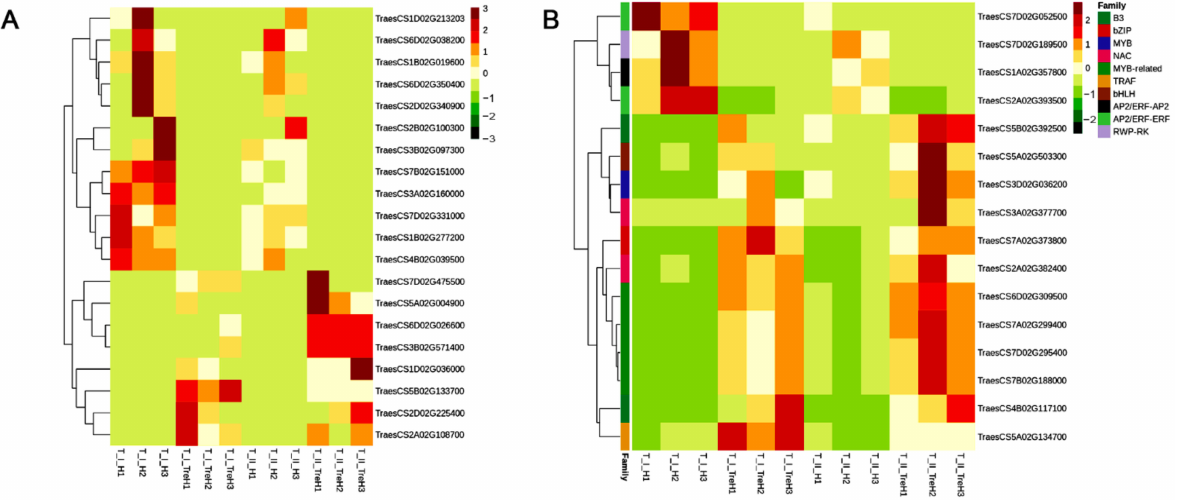
Figure 8. Heatmap of trehalose response candidate genes and transcription factors. T—the tran- scriptome; I—Yangmai 18; II—Yannong 19; CK—control group; H—heat stress treatment for 24 h; Tre—trehalose pretreatment for 3 d; TreH—trehalose pretreatment for 3 d followed by high- temperature treatment for 24 h. ( A ) Heatmap of trehalose response candidate genes. The abscissa represents the sample name and the ordinate represents the ID of genes. Red indicates high expres- sion and green indicates low expression. ( B ) Heatmap of trehalose response candidate transcription factors. The abscissa represents the sample name, and the ordinate represents the ID of transcription factor genes and their families. Red indicates high expression and green indicates low